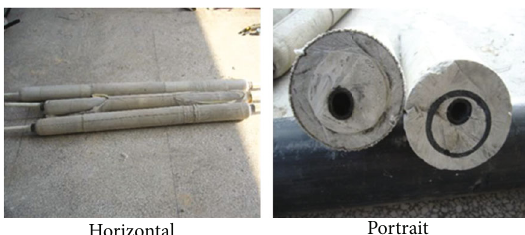
Figure 10: Schematic diagram when gas and water are completely discharged.